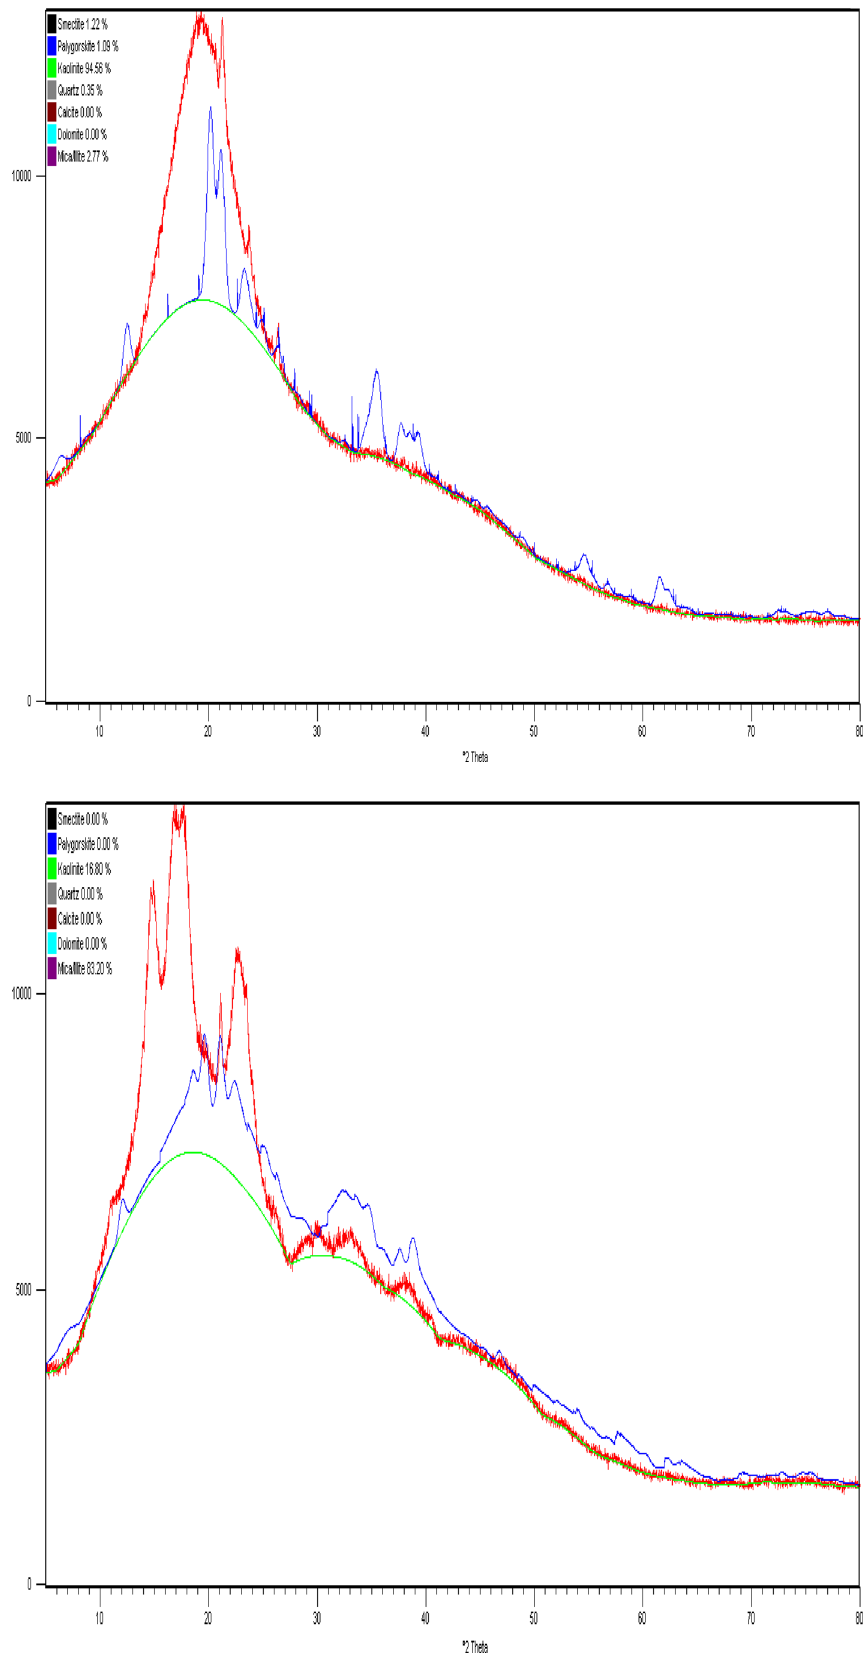
Fig. 5 X-ray diffraction pattern of MSA